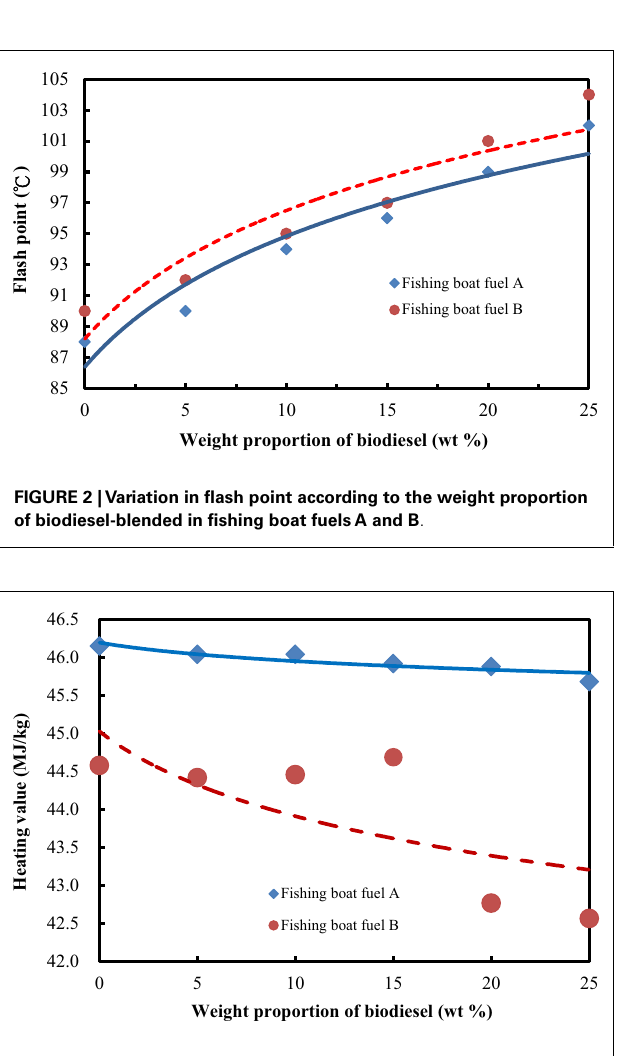
FIGURE 3 |Variation in heating value according to the weight proportion of biodiesel-blended in fishing boat fuelsA and B